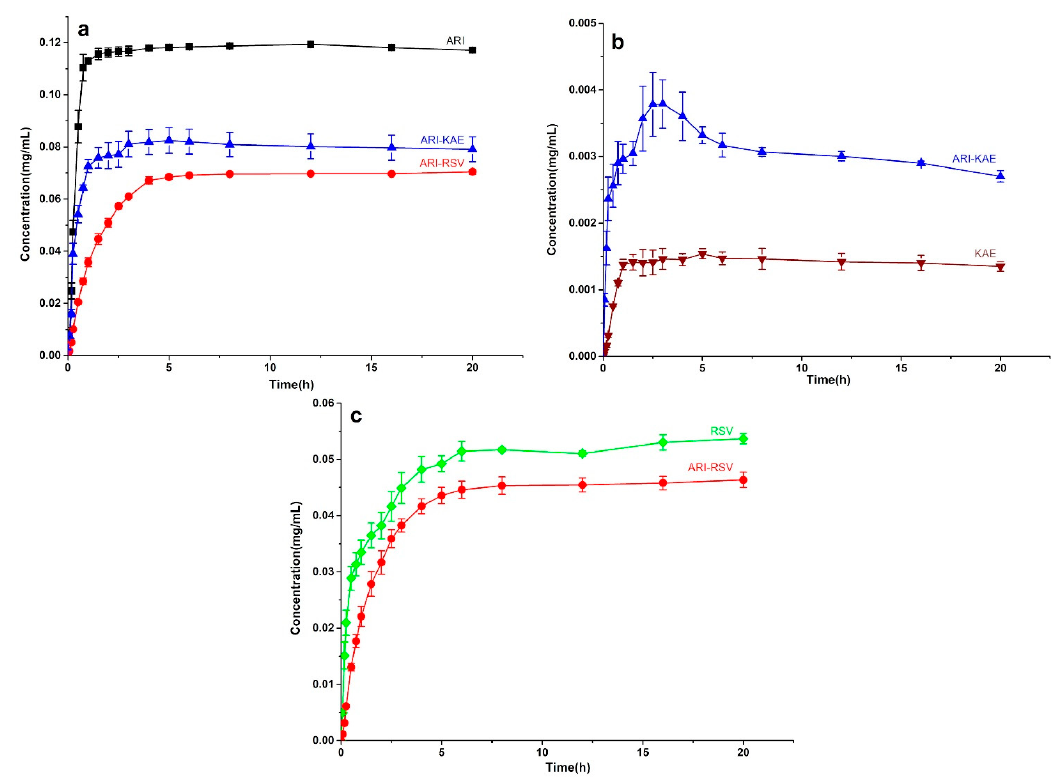
Molecules 2021 , 26 , x FOR PEER REVIEW Figure 11. The dissolution profile of ARI-KAE and ARI-RSV at pH = 4.0 acetate buffer, ( a ) ARI from pure ARI, ARI-RSV, and ARI-KAE, ( b ) KAE from pure KAE and ARI-KAE, ( c ) RSV from pure RSV and ARI-RSV.